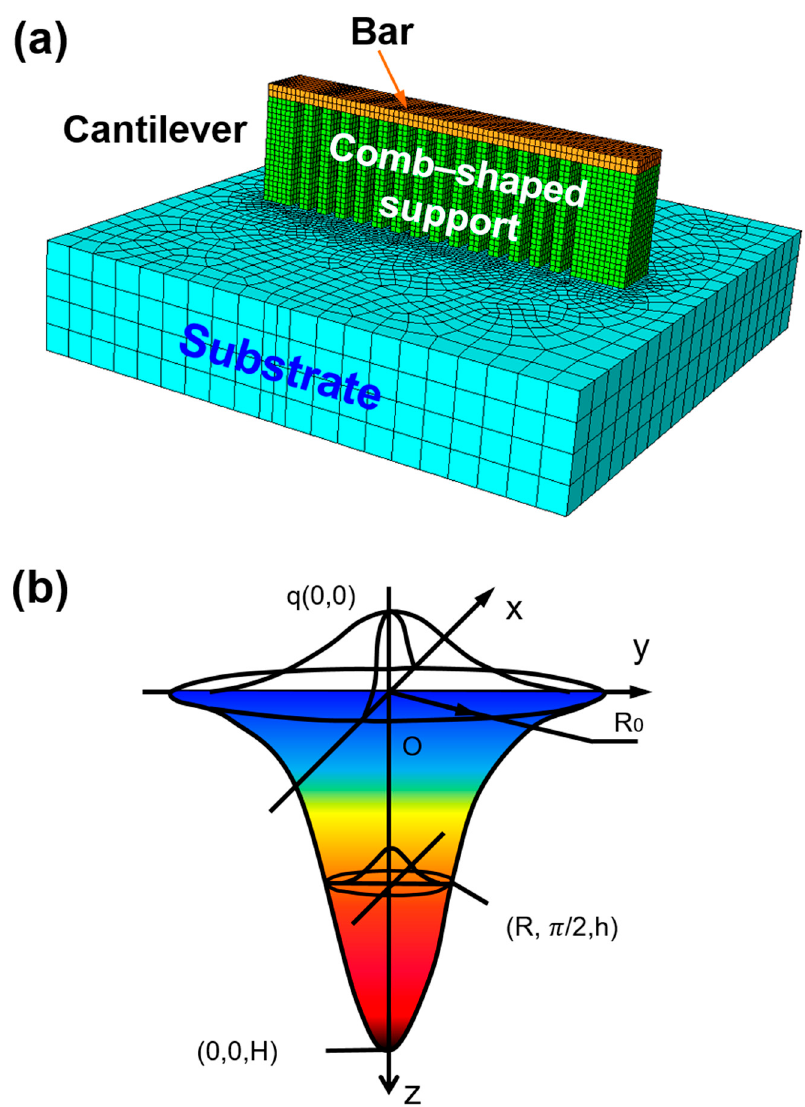
Figure 1. ( a ) Three-dimensional coupled thermo-mechanical finite element model and ( b ) representative heat input modeling with Gaussian distribution.